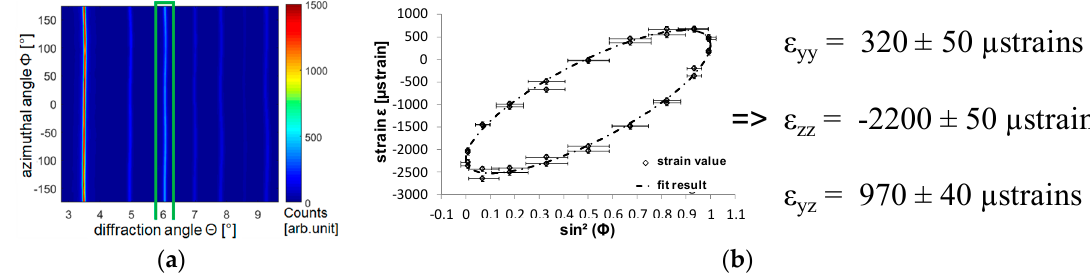
Figure 2. ( a )Azimuthally integrated (caked) diffraction image of a single measurement point; ( b ) strain results from this diffraction image, fit to the measurement according to Equation (1).